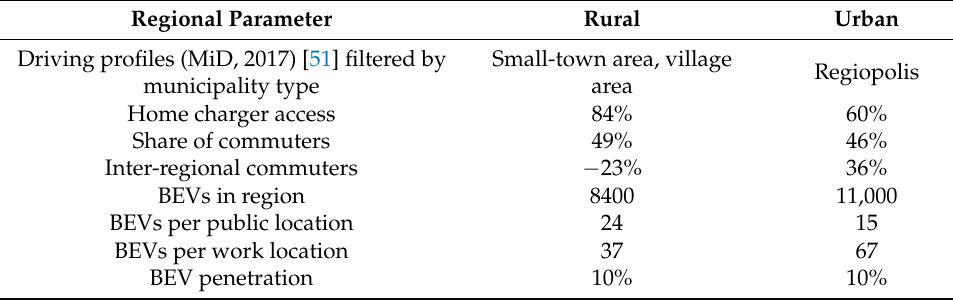
Table 1. Rural and urban regional parameter set considering 10% BEV